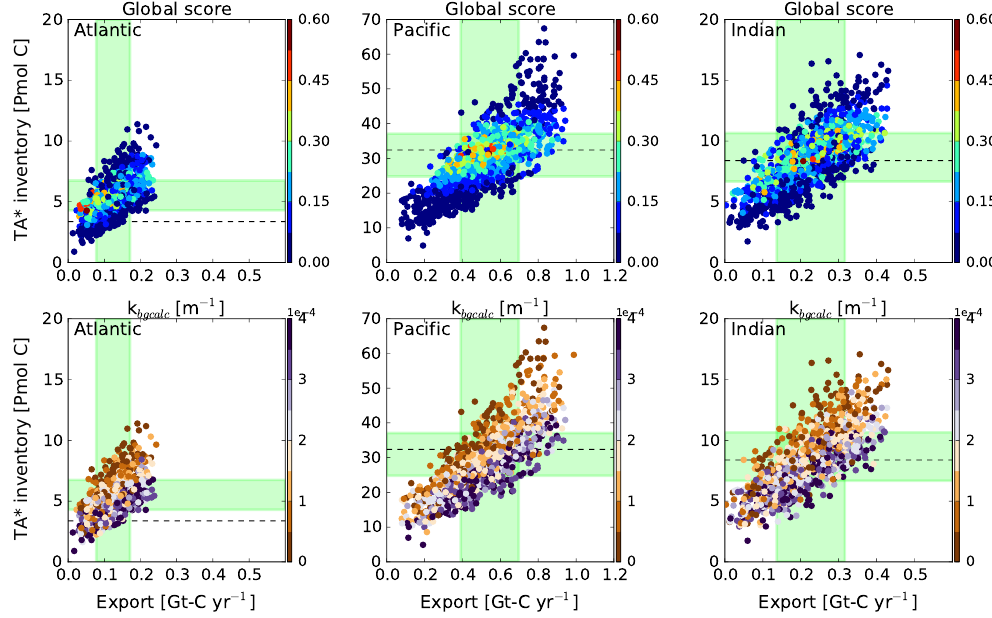
Figure 9. The simulated TA ∗ inventory vs. the simulated CaCO 3 export of each ensemble member, coloured according to model skill (top) and background dissolution rate (bottom) for the Atlantic, Pacific, and Indian Ocean (columns). Each circle represents results from an individual simulation. Green shadings show the 68% confidence range in basin-wide TA ∗ inventories and CaCO 3 export of the constrained model ensemble, and black dashed lines indicate the estimated TA ∗ inventories based on the observations including the sediment correction. Runs with low and high background dissolution can skillfully represent the TA ∗ distribution. Runs with a higher CaCO 3 export tend to require a higher background dissolution to achieve a good